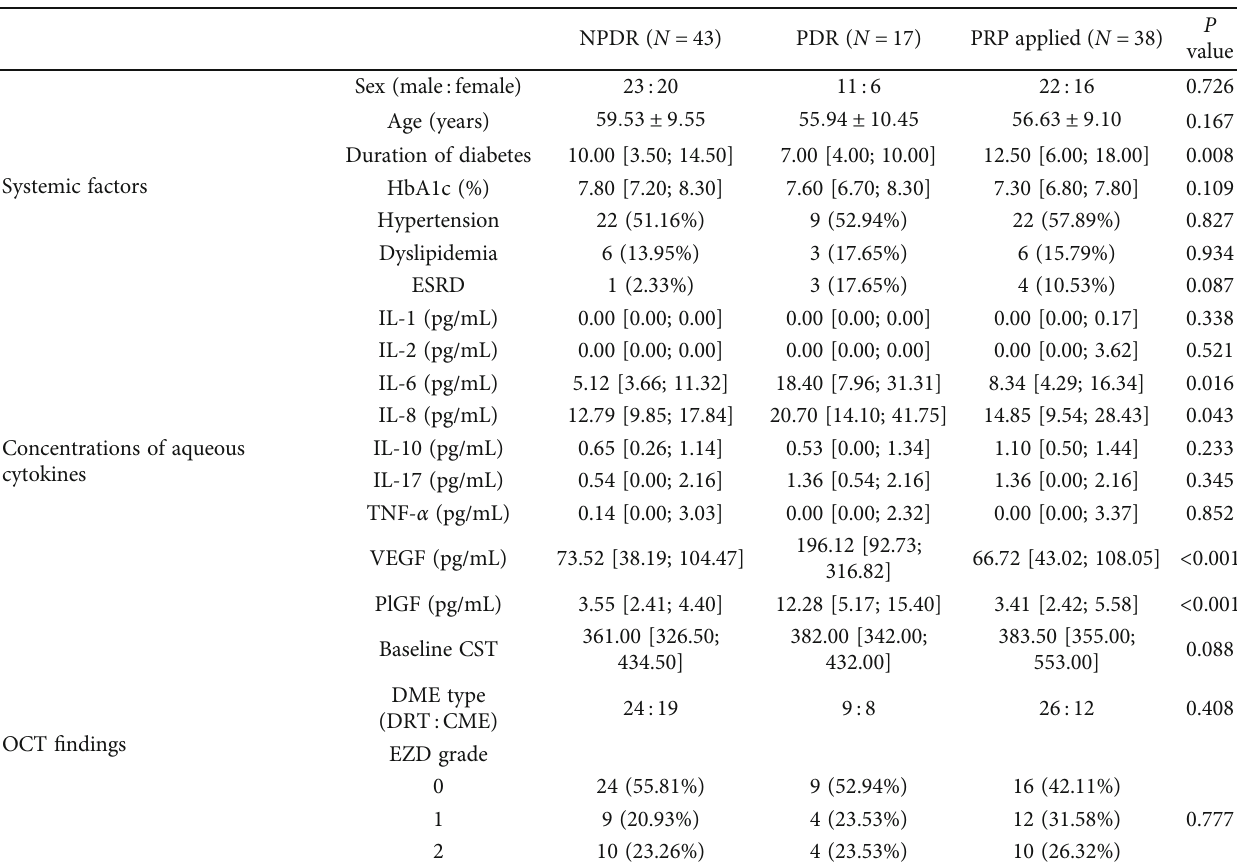
Table 1: Demographic features depending on DMR